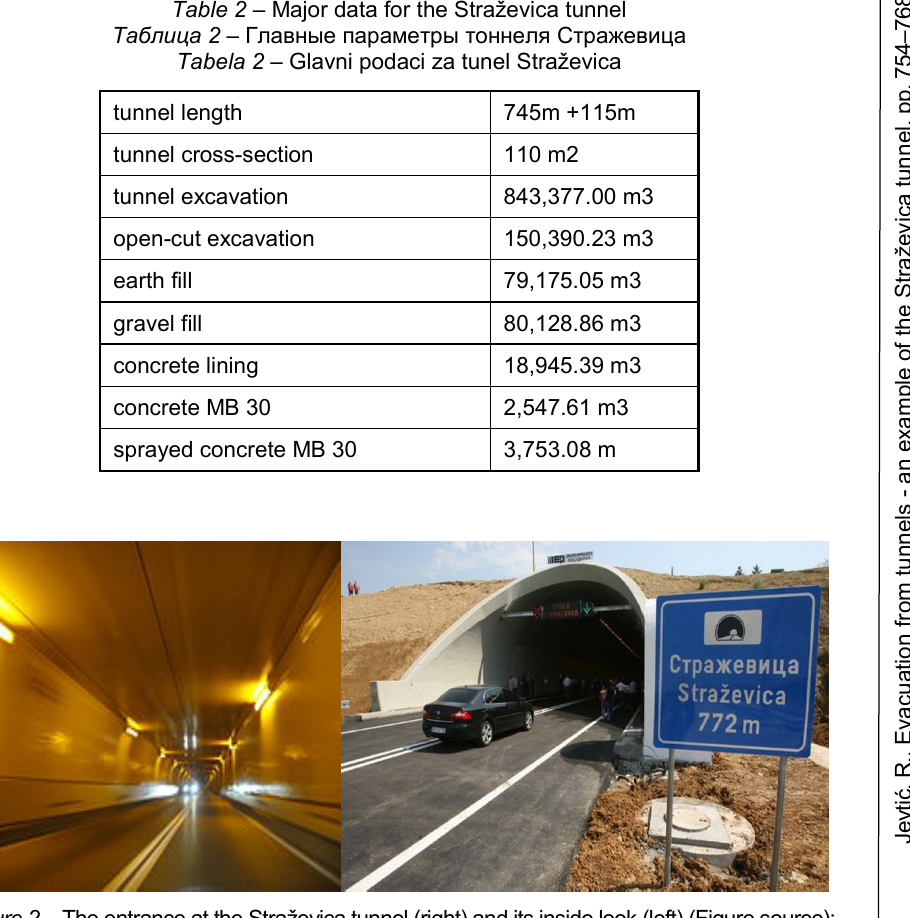
Figure 2 – The entrance at the Straževica tunnel (right) and its inside look (left) (Figure